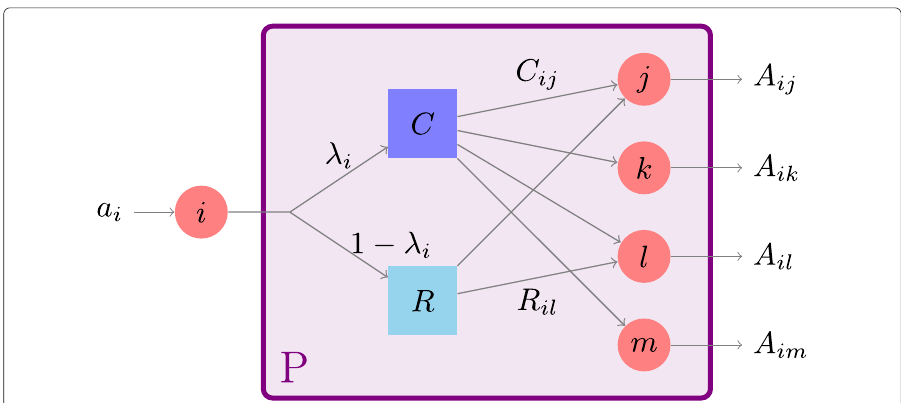
Fig. 2 Schematic of the mechanism governing a rADN model. Node i ∈ V activates with rate a i . Then, with probability λ i it generates a connection due the community-based mechanism, i.e., following the probabilities in the community matrix C . Otherwise, with probability 1 − λ i , the link is caused by the backbone in matrix R . These mechanisms yield the corresponding link activation rates in matrix